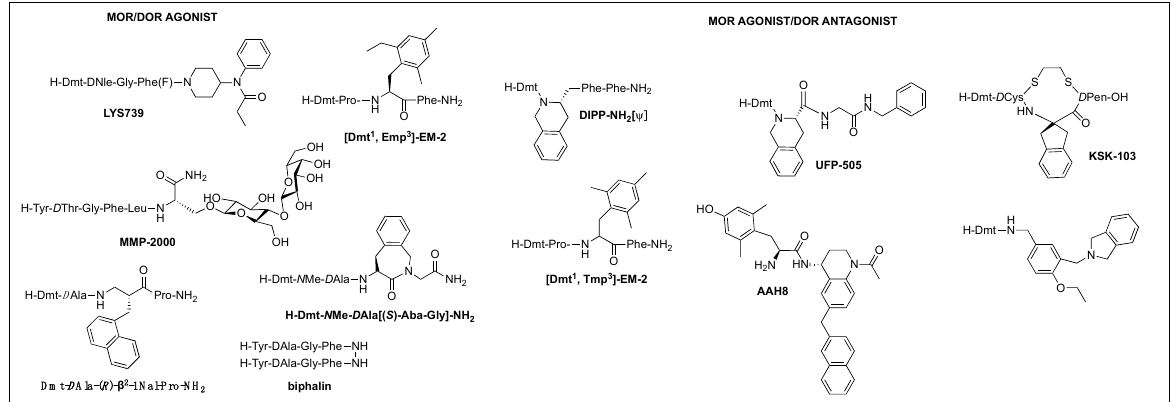
Figure 3. Multifunctional opioid peptidomimetics: MOR/DOR agonist, MOR agonist/DOR antagonist.